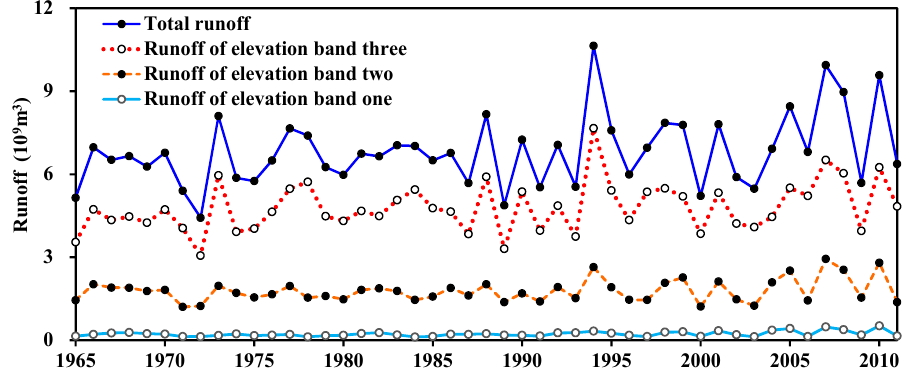
Figure 9. Annual runoff of different elevation bands.